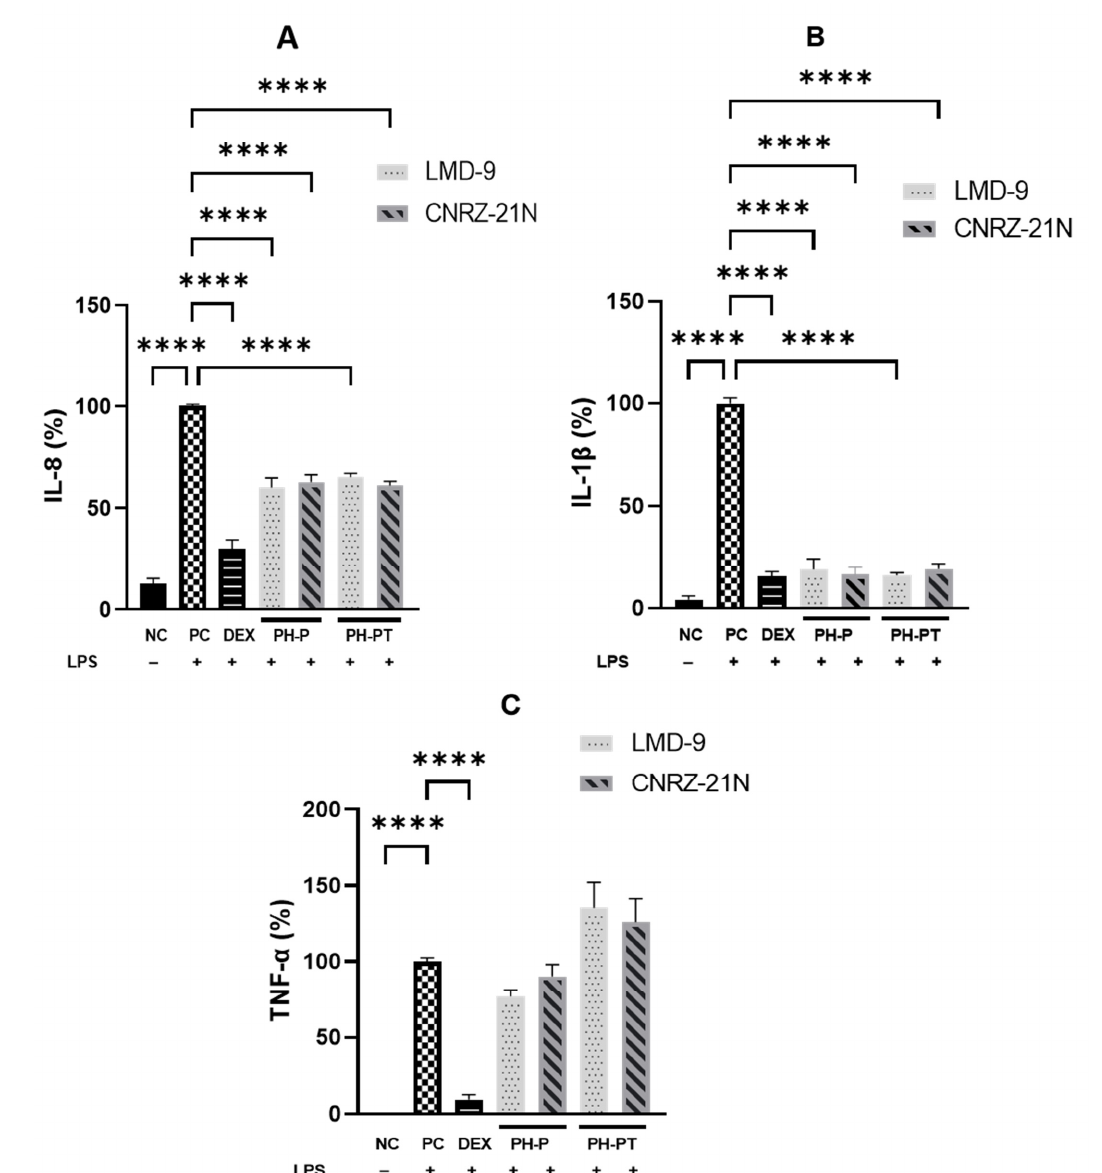
Figure 1. Anti-inflammatory activity highlighted in vitro of hydrolysates recovered after peptic shaving (PH-P), or after peptic shaving followed by trypsinolysis (PH-PT) of S. thermophilus LMD-9 and CNRZ-21N. The effect of peptide hydrolysates on secretion of IL-8 ( A ), IL-1 β ( B ), and TNF- α ( C ) cytokines in LPS-stimulated THP-1 macrophages. Three hour co-incubation of THP-1 macrophages was performed either with LPS (50 ng/mL) alone or with LPS and (i) PH-P (3 mg/mL) or (ii) PH-PT (3 mg/mL) or (iii) dexamethasone (DEX, 25 µ M). After 3 h, the TNF- α , IL-1 β , and IL-8 secretion levels were quantified in the cell culture medium by ELISA. The negative control (NC) repre- sents the incubation of untreated cells. IL-8 (%), TNF- α (%), and IL-1 β (%) are the percentages of IL-8, TNF- α , or IL-1 β , respectively, secreted by cells relative to their production by only LPS-treated cells (PC). All data are represented as the means ± SEM of three experiments performed independently (N = 3). **** p <